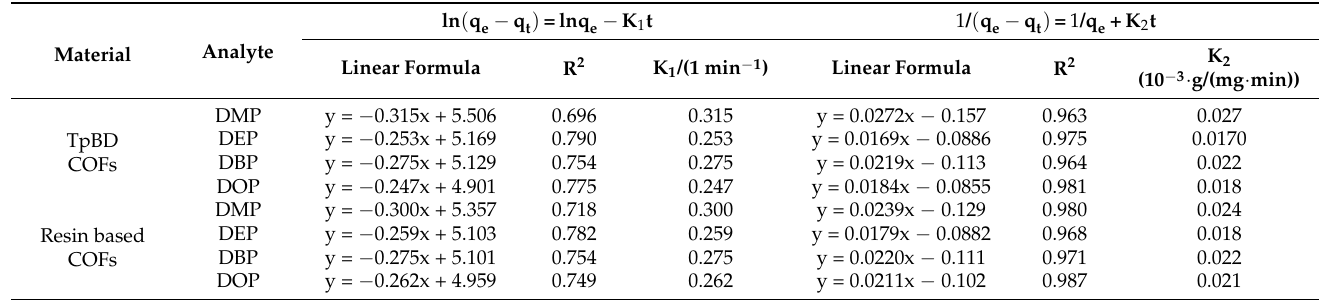
Table 3. Kinetic parameters of PAEs.